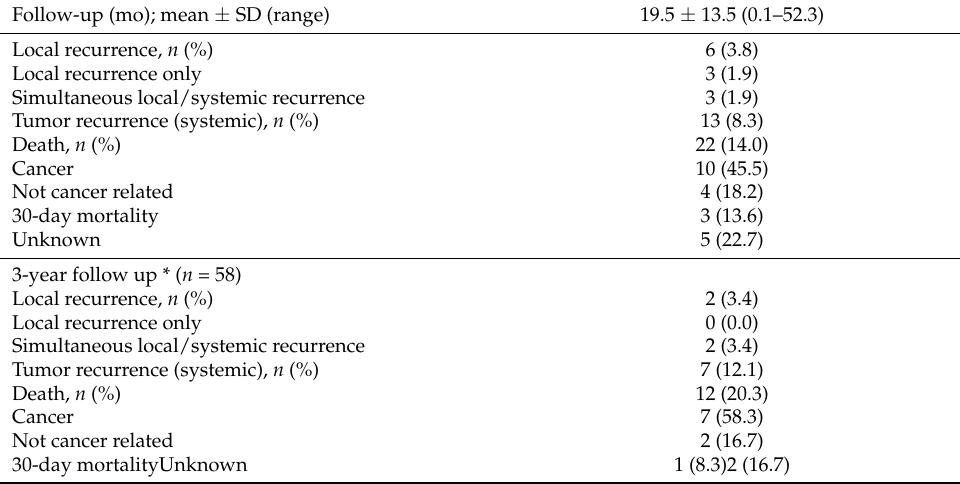
Table 5. Oncological outcome ( n =